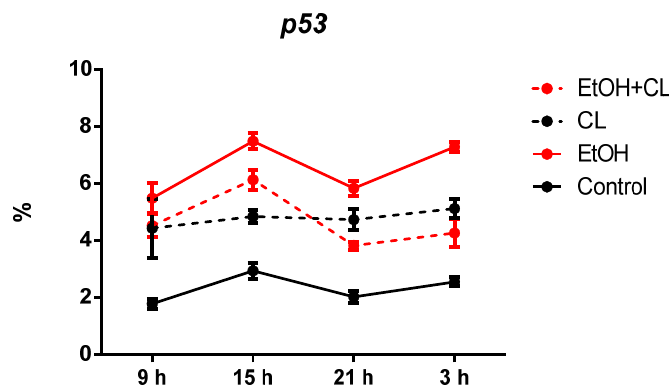
Figure 17. Daily dynamics of p53 expression in hepatocytes of rats.